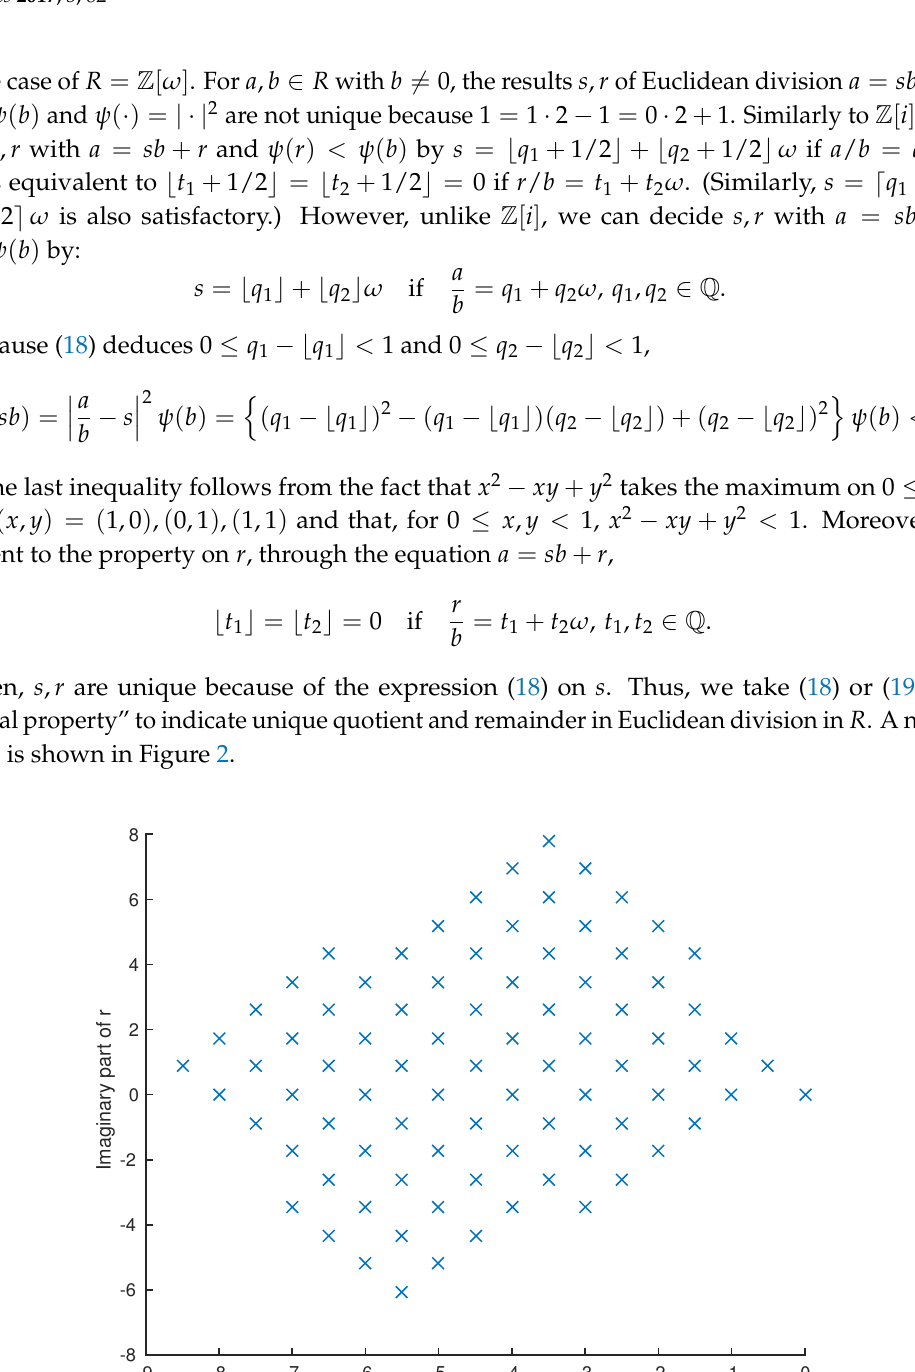
∞ c h p h h = w c h p h ∈ Q p h < 0